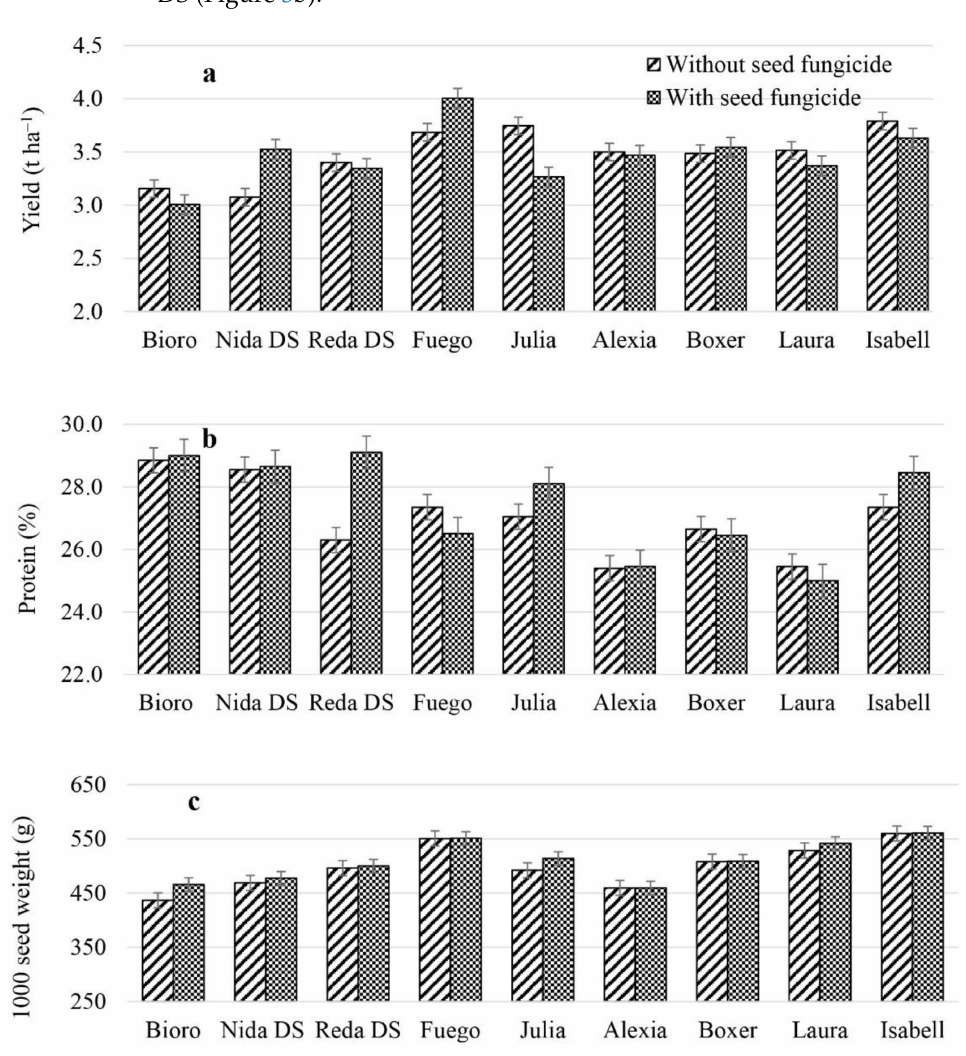
Figure 3. Treatment × variety interaction effects on seed yield ( a ), protein content ( b ), and 1000 seed weight ( c ) of nine faba bean varieties, in average in the first and second season. The error bars show standard